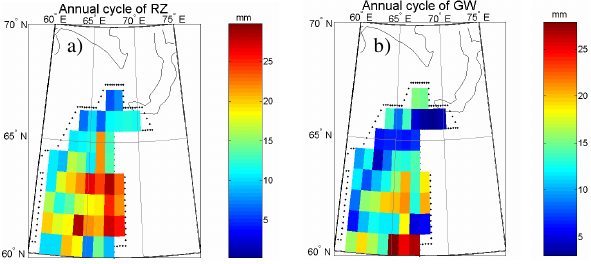
Fig. 9. Amplitude of the annual cycle over 2003–2004 of the com- Figure 9. Amplitude of the annual cycle over 2003-2004 of the components of the TSS: a) 1 ponents of the TSS: (a) water in the Root zone from hydrological Water in the Root zone from hydrological models, b) Groundwater and permafrost. Units: 2 mm. 3 models, (b) groundwater and permafrost. Units: